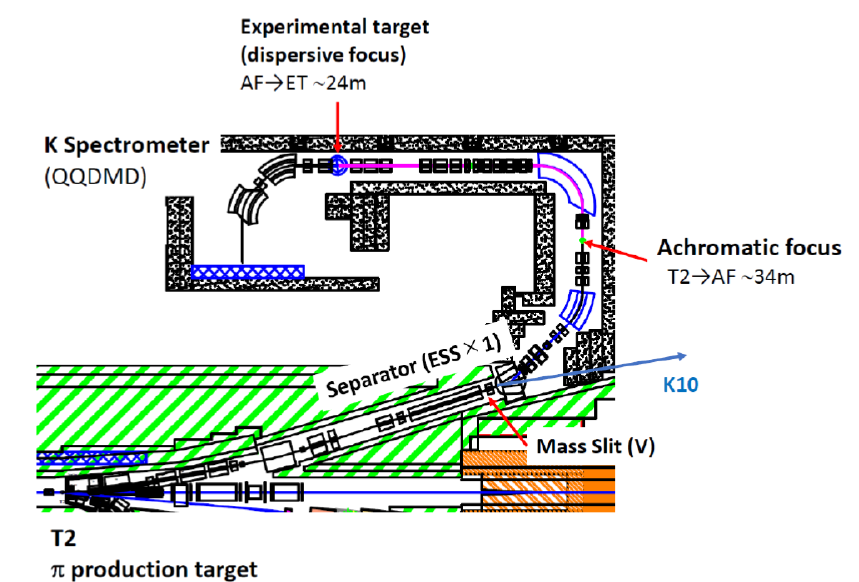
Figure 7. Schematic illustration of the HIHR beamline with a kaon spectrometer